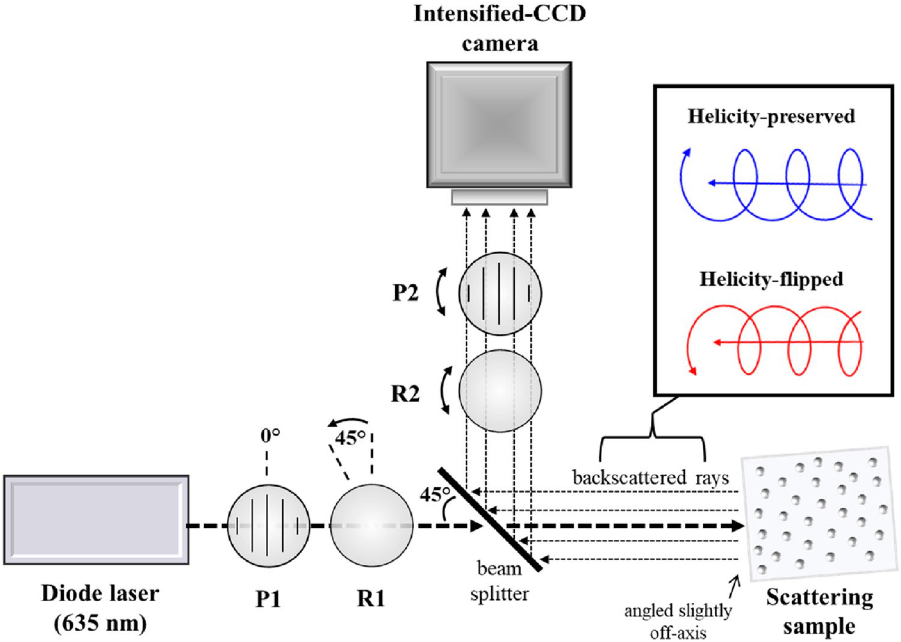
Figure 1. The schematic of the experimental system used to capture helicity-flipped and -preserved images of 180° backscattered circularly polarized light from polystyrene microsphere suspensions of varying scatterer size and scattering coefficients. A diode laser (λ = 635 nm) illuminated each sample, and an intensified-CCD (ICCD) camera imaged a fraction of the backscattered light reflected by a beam splitter. A linear polarizer (P1) and quarter wave retarder (R1) yielded incident left-circularly polarized light; a linear analyzer (P2) and quarter wave retarder (R1) transmitted right-circularly (flipped) and left-circularly (preserved) polarized components of the backscattered light. The sample was angled slightly off-axis to avoid detection of specular